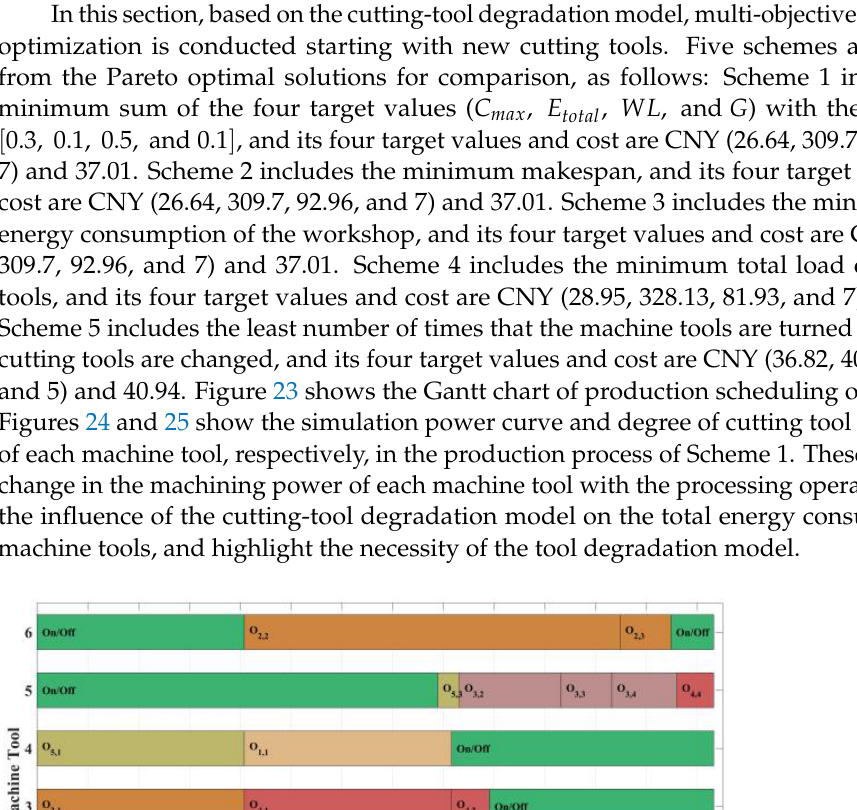
Figure 22. Gantt chart of an instance.